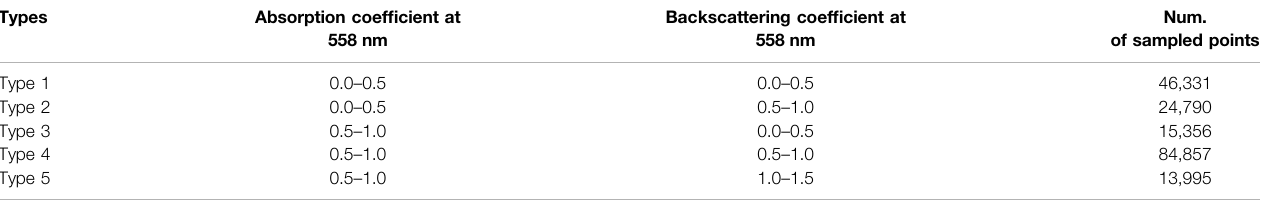
TABLE 2 | Taihu Lake water types based on the IOPs at 558 nm (Green Band).